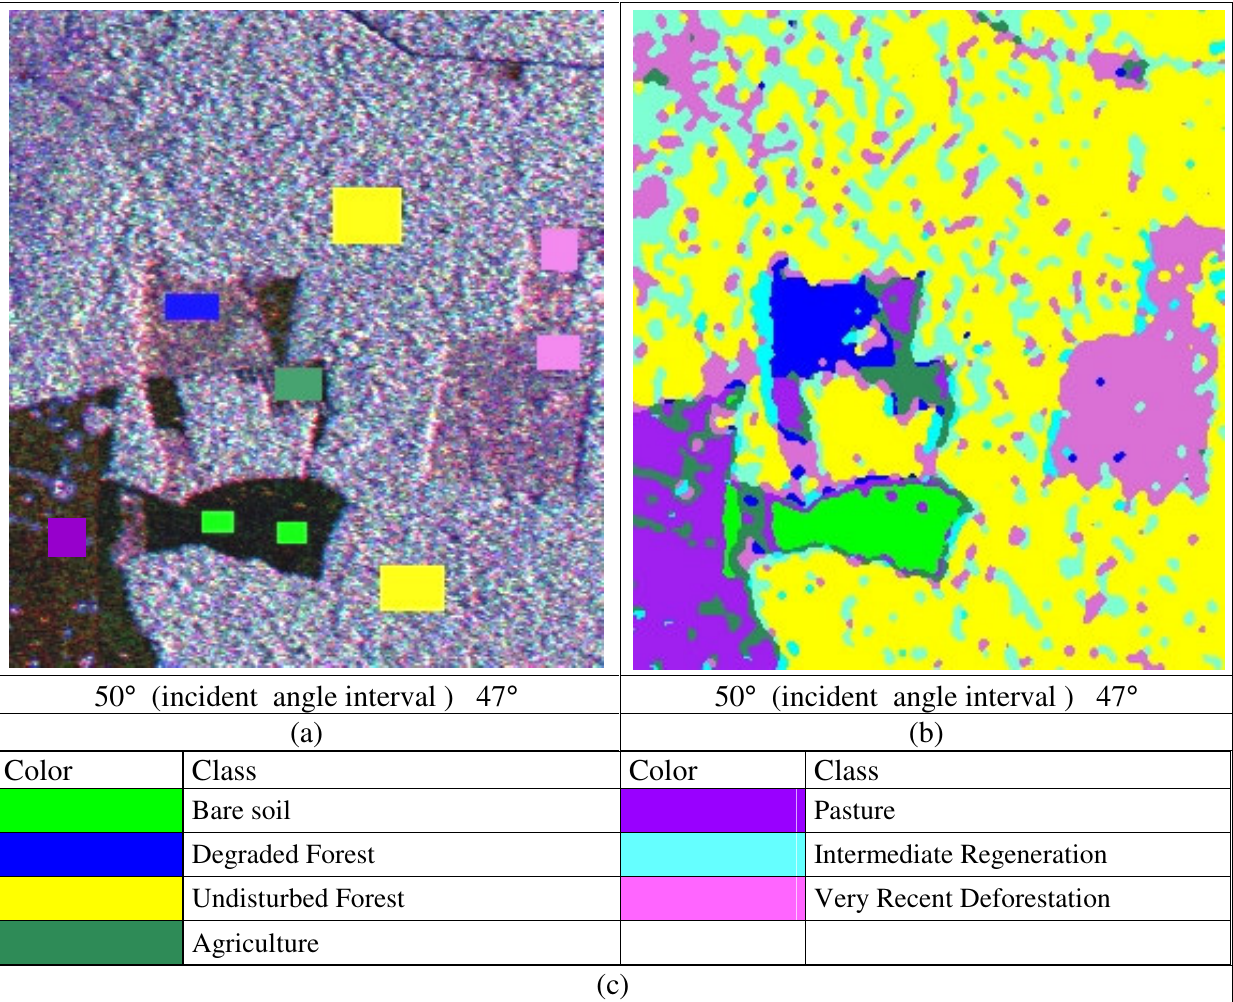
Figure 10. (a) RGB Color composition of the HH, VV e HV simulated MAPSAR images; (b) Classification map using all three polarization channels, (c) Land Cover/Use